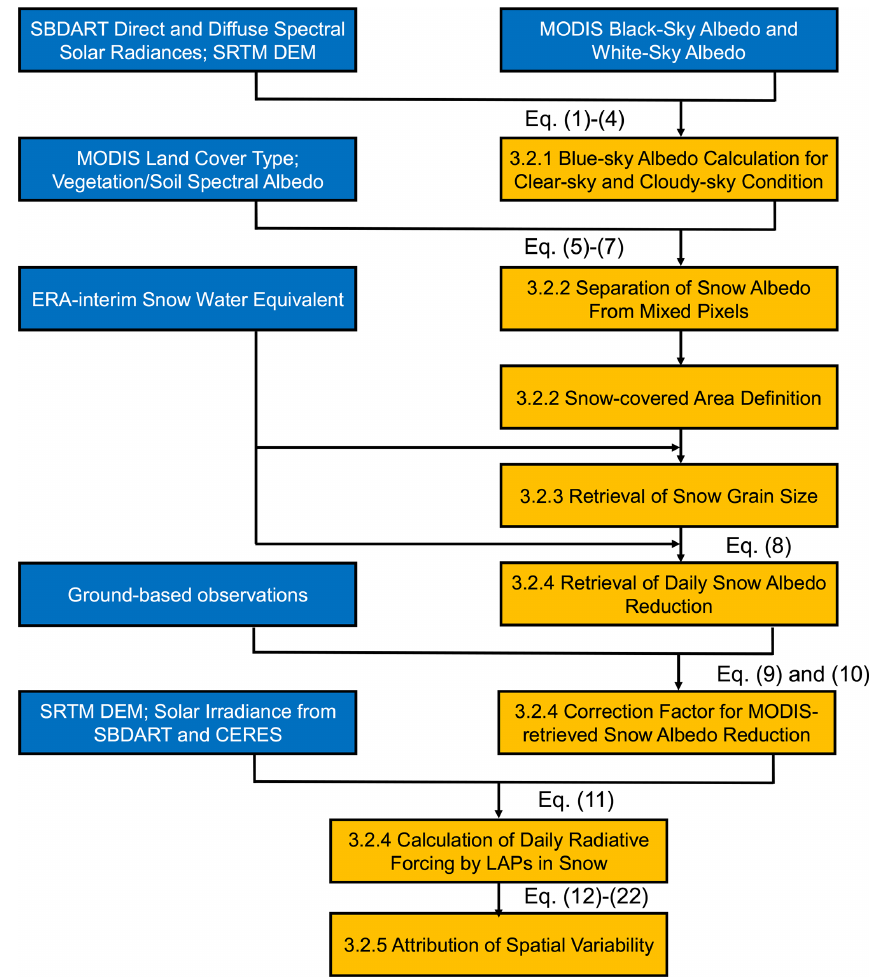
Figure 2. Workflow depicting the calculation and validation of radiative forcing of LAPs in snow: the blue boxes denote the external input data, while the orange boxes are used for calculations in this